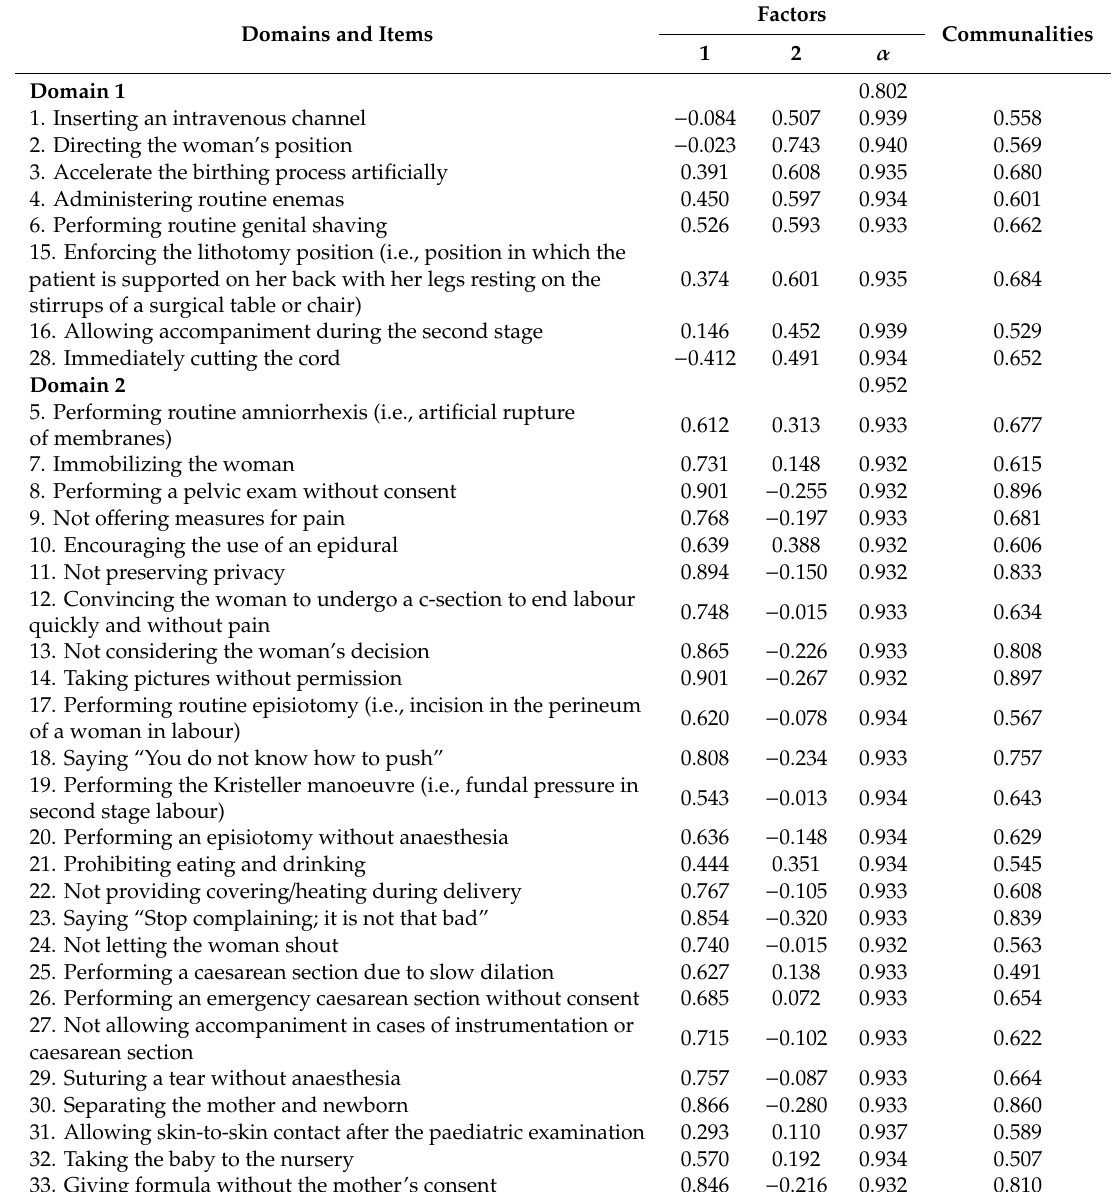
Table 2. Matrix of components and results of the factor analysis of the PercOV-S (Perception of Obstetric Violence in Students) instrument (N =